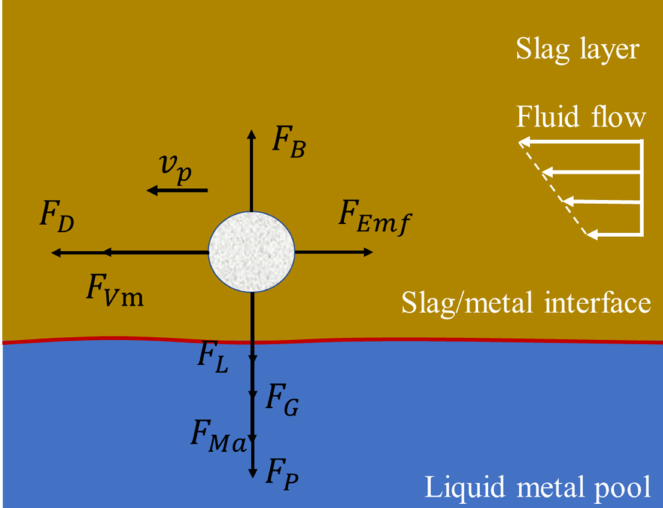
Figure A1. Schematic diagram of force analysis of